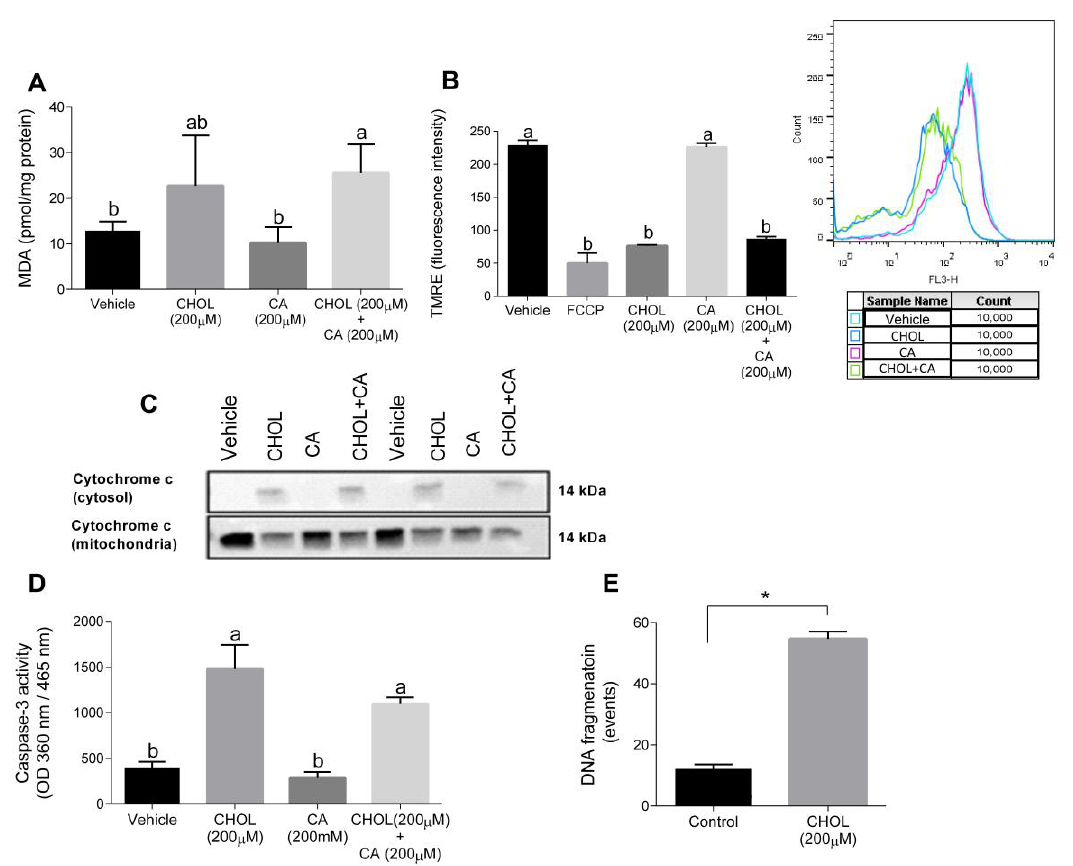
Figure 8. Cholesterol induces oxidative, mitochondrial stress and apoptosis in HSC-T6. HSC-T6 were exposed for 12–24 h to cholesterol (CHOL, 200 µ M), cholic acid (CA, 200 µ M), cholesterol with cholic acid (CHOL + CA, 200 µ M) or the vehicle (treated with 0.1% DMSO). ( A ) HSC-T6 MDA cell content. ( B ) HSC-T6 mitochondrial membrane potential. ( C ) Cytochrome c leakage from mitochondria to cytosol 12 h post-treatment. ( D ) Caspase-3 activity 12 h post-treatment. ( E ) DNA fragmentation 24 h post-treatment. All values are expressed as the mean ± SD. Columns marked with * are different from control according to Student’s t -test. ( p < 0.05), n = 4. Columns marked with different letters (a, b) are significantly different ( p < 0.05) in the Tukey-Kramer post-hoc test. FCCP, potent uncoupler of mitochondrial oxidative